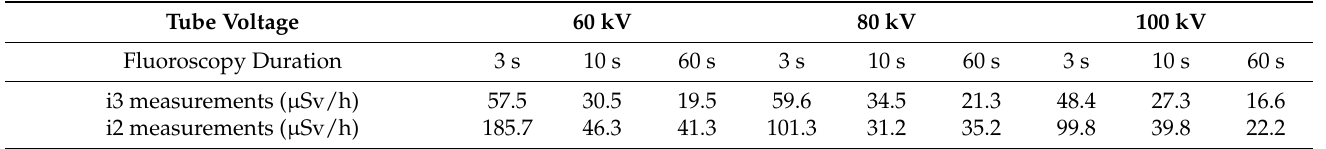
Table 3. Low radiation detection limit of the i2 and i3 systems.